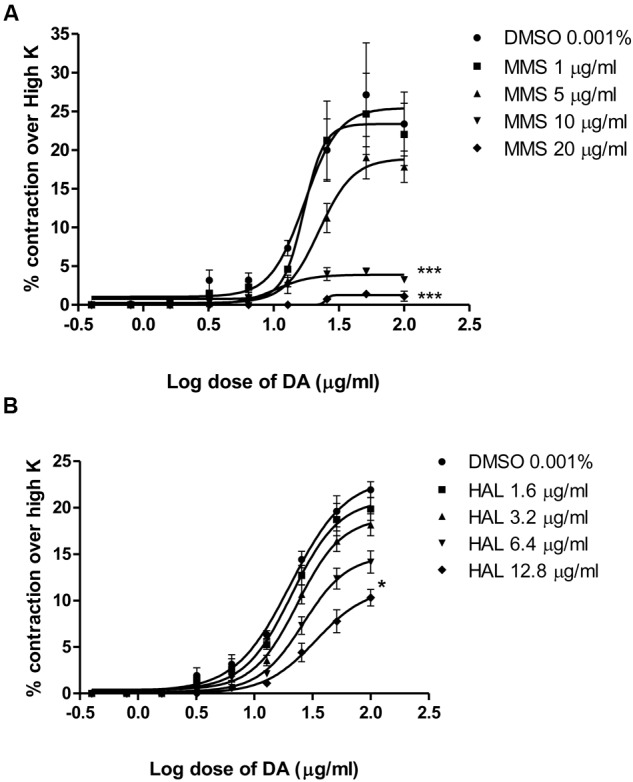
Log dose response curves of dopamine in the absence and presence of (A) MMS and (B) haloperidol (HAL) expressed as % contraction over 80 mM High K. ∗p < 0.05, ∗∗∗p < 0.001 when compared with DMSO; n = 4.